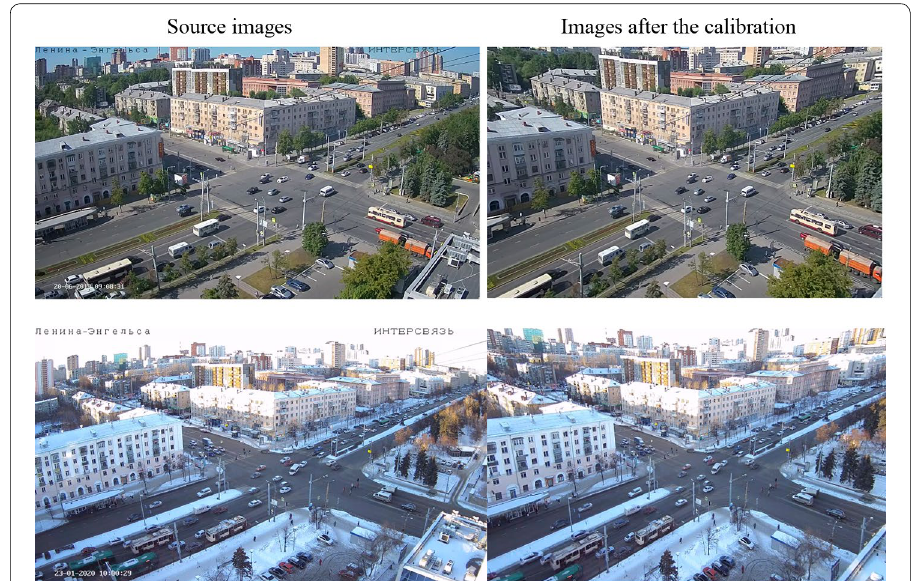
Fig. 12 Source and corrected camera images